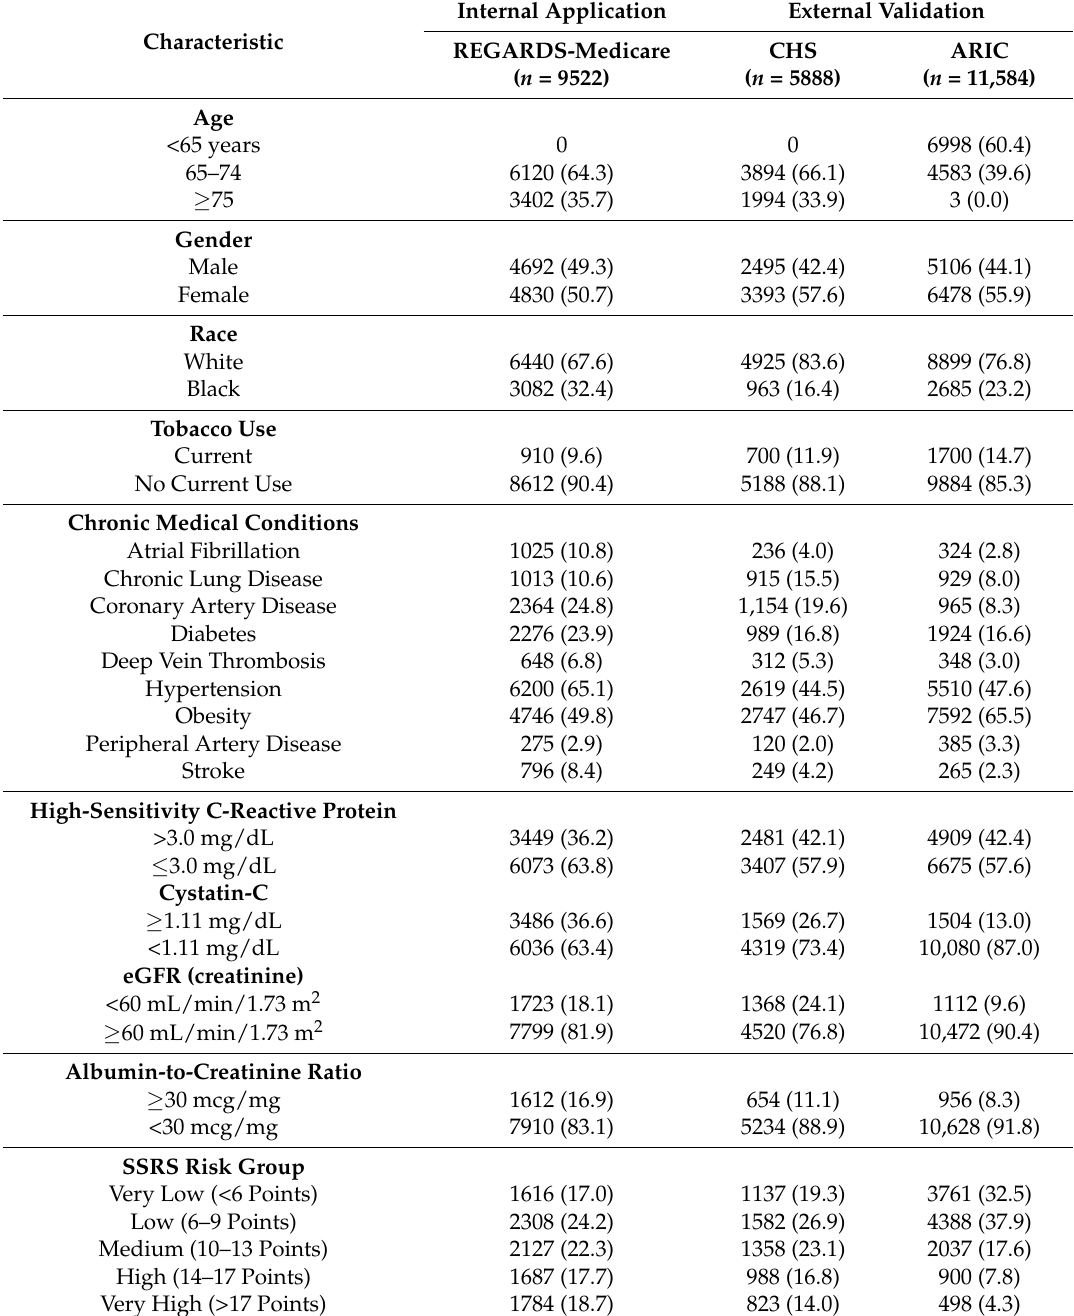
Table 2. Baseline participant characteristics by